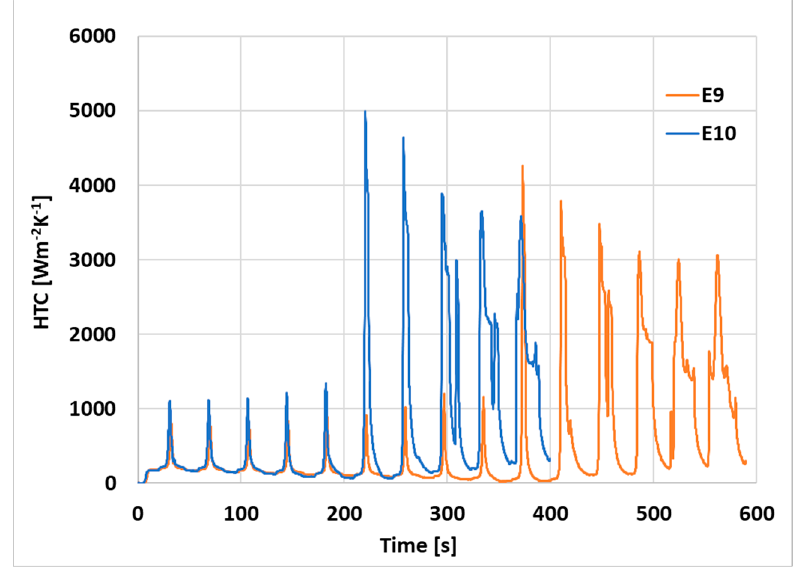
Figure 5. HTC record for experiments E9 and E10, data for position of the nozzle axis.